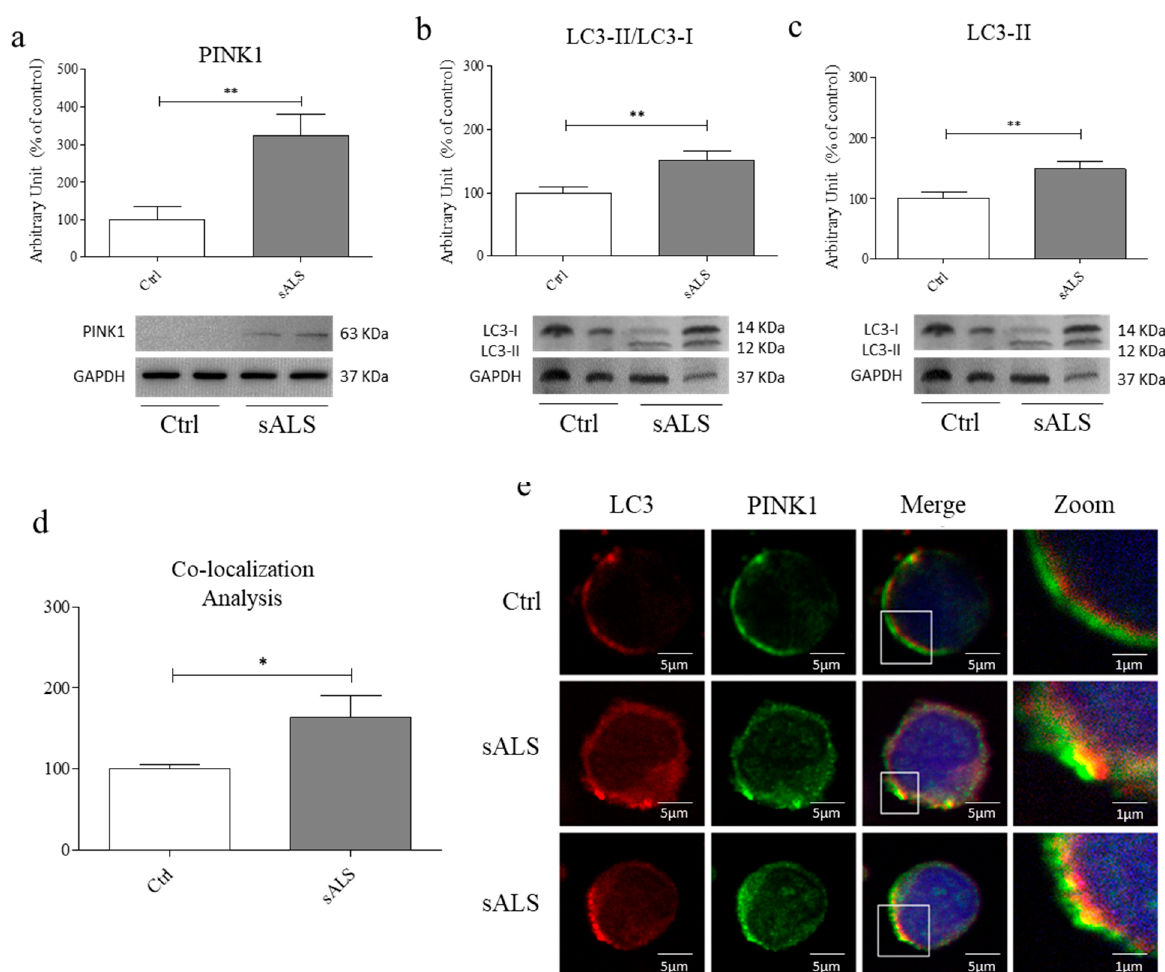
Figure 2. Mitophagy pathway increases in PBMCs of sALS patients. ( a ) In PBMCs of sALS patients, we observed a statistically significant increase in PINK1 expression levels (** p < 0.01). N = 32 ( b ) In PBMCs of sALS patients we observed a statistically significant increase in LC3-II/LC3-I ratio (** p < 0.01). N = 32 ( c ) In PBMCs of sALS patients we observed a statistically significant increase in LC3-II expression levels (** p < 0.01). We used GAPDH as a loading control. N = 32 ( d , e ) Analysis of the co-localization (merge) between LC3 and PINK1 in PBMCs of healthy controls and sALS patients by confocal microscopy analysis. We found an increased co-localization in sALS PBMCs (* p < 0.05). Red: LC3, Green: PINK1. Magnification: 63X, scale bar: 5 μ m. Zoom: X4, scale bar 1 μ m. N = 3.